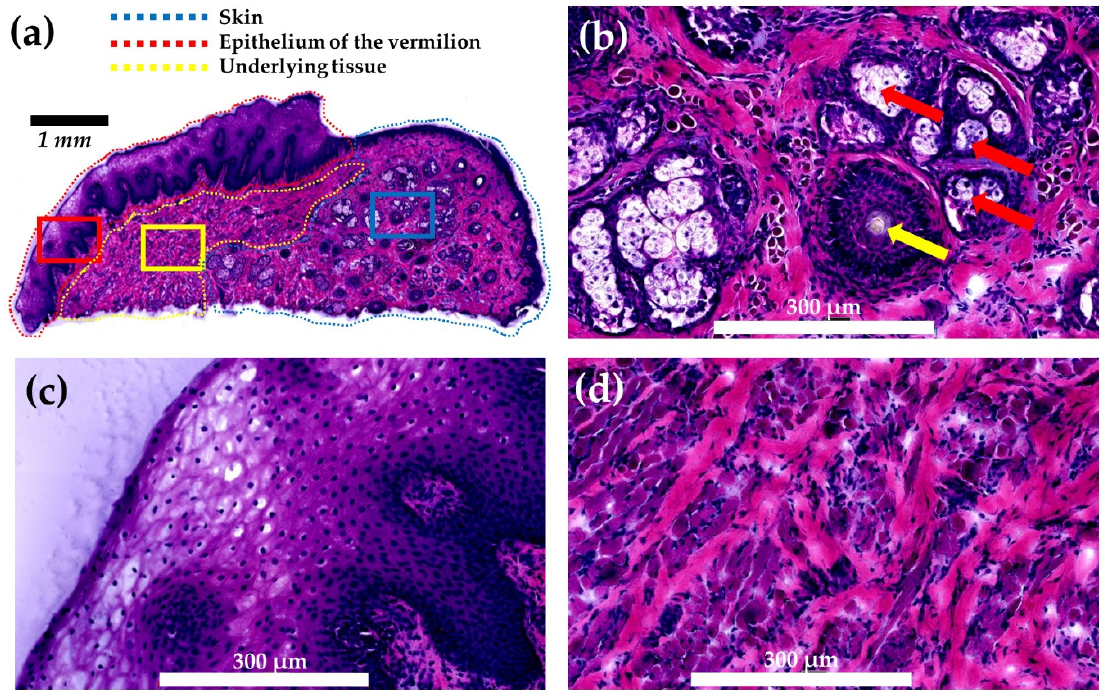
Figure 1. Histology of lip tissue under this study. The tissue obtained from subject 2 was stained with hematoxylin and eosin. ( a ) Whole tissue section showing the skin, epithelium of the vermilion, and its underlying tissue. Magnified view of ( b ) the skin showing the hair follicle (indicated by yellow arrow) and sebaceous glands (indicated by red arrows). Magnified view of ( c ) the epithelium of the vermilion, and its ( d ) underlying tissue. Areas encircled by blue, red, and yellow rectangles in ( a ) were used for magnification for the skin, epithelium of the vermilion, and its underlying tissue, respectively.